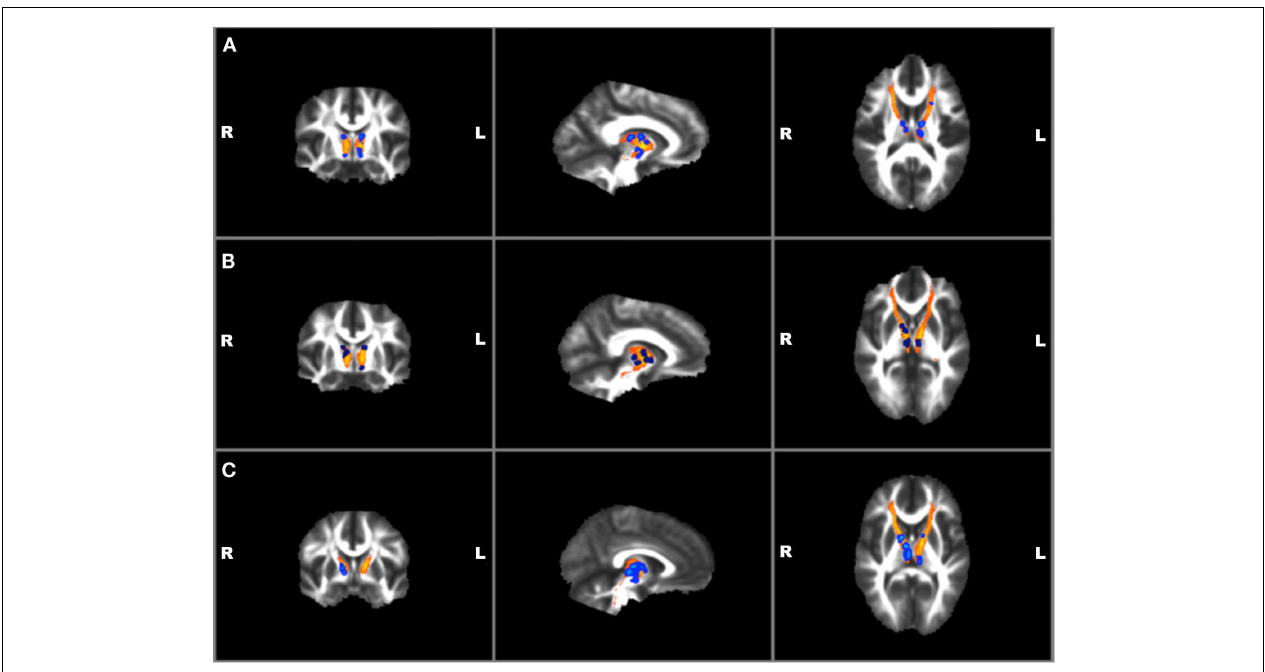
withTBI + SB compared to HC; (B) individuals withTBI + SB and the combined group ofTBI-SB and HC; (C) individuals withTBI + SB and TBI-SB . * Significant blue regions were filled in byTBSS_fill to improve